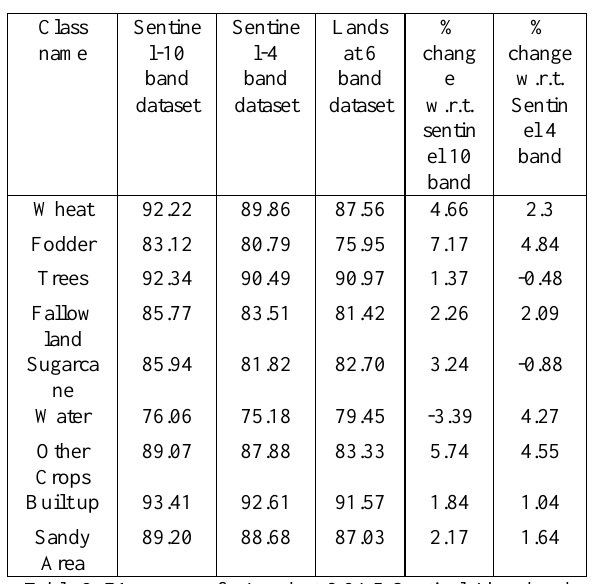
Table 2. F1-measure for Landsat-8 OLI, Sentinel 4 band and Sentinel 10 band using RF algorithm and change in percentage accuracy with respect to (w.r.t.) Landsat-8 OLI.